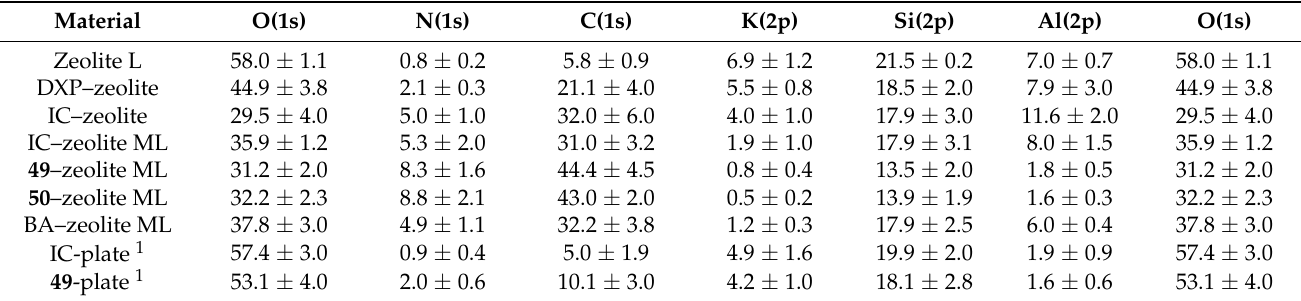
Table 2. XPS analysis results (atomic %) for zeolite L materials and the peptide monolayers; mean ± SE of three to four analyses. Bare zeolites showed very low C(1s) and N(1s) signals; these percentage values increased significantly and consistently to the subsequent functionalization